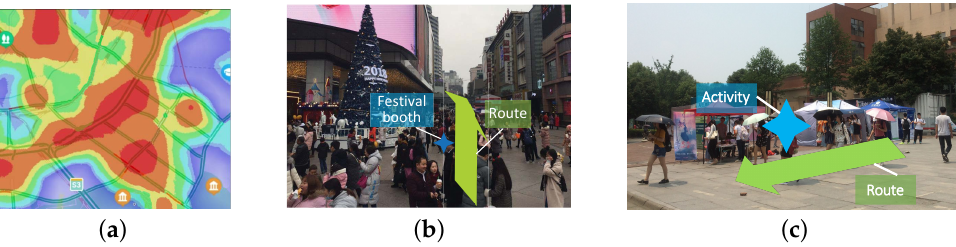
Figure 2. An example of a business event: ( a ) Heat map of crowds; ( b ) Festival booth; ( c ) Business event in